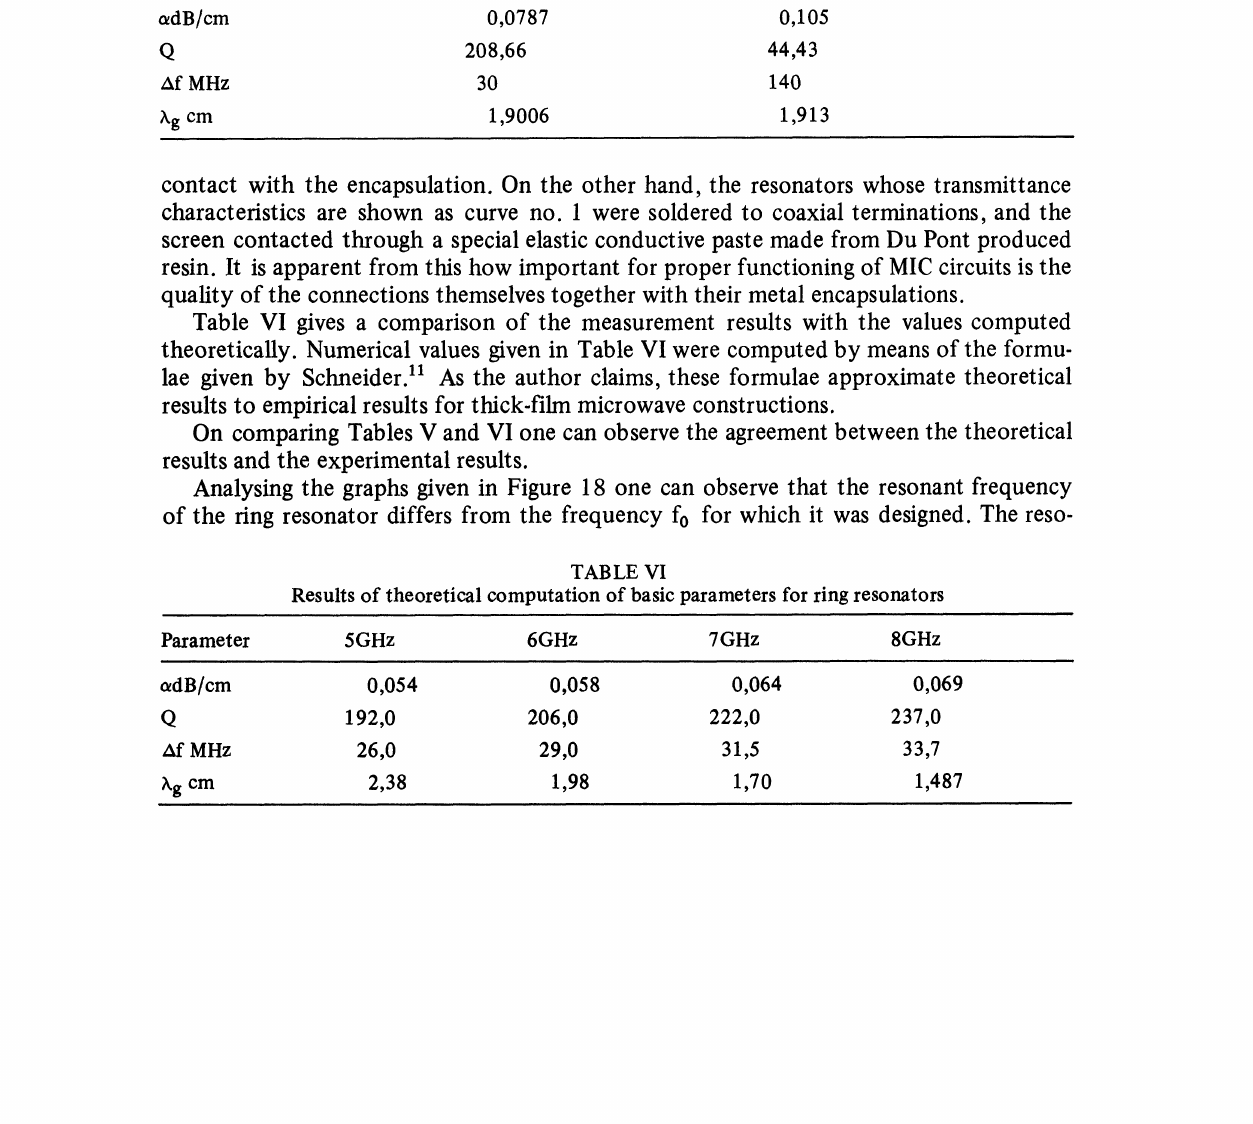
FIGURE 18 Transmittance vs Frequency Characteristic for ring resonators, fo 9GHz. TABLE V Results of measurements of models of ring resonators made with the use of thick-film technology Parameter Curve no. Curve no. 2 (solid line) (broken